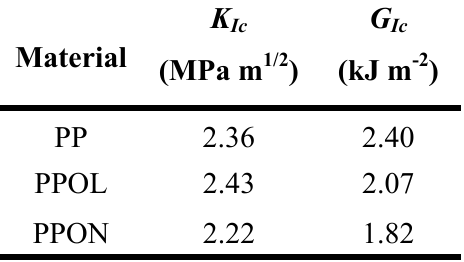
composites (20 vol.%). Average size for OL 3